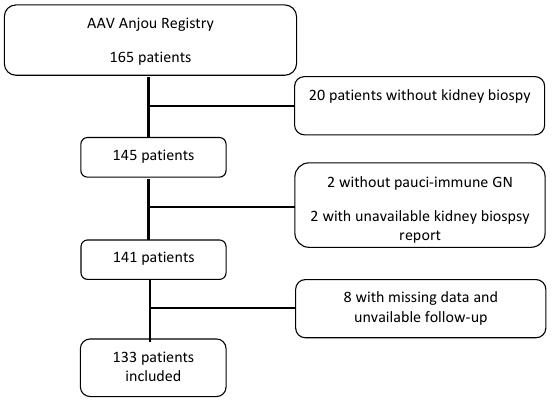
Figure 1. Flowchart of the study.